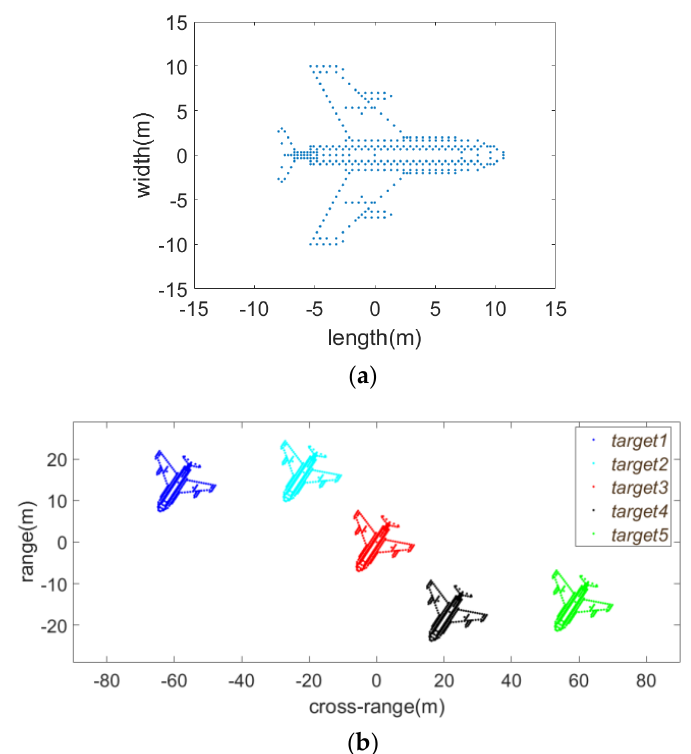
Figure 9. Simulated group targets: ( a ) simulated aircraft; ( b ) spatial distribution of simulated aircraft. Parameters of radar and group targets are shown in Tables 1 and 2, respectively. Table 1. Parameters of radar.